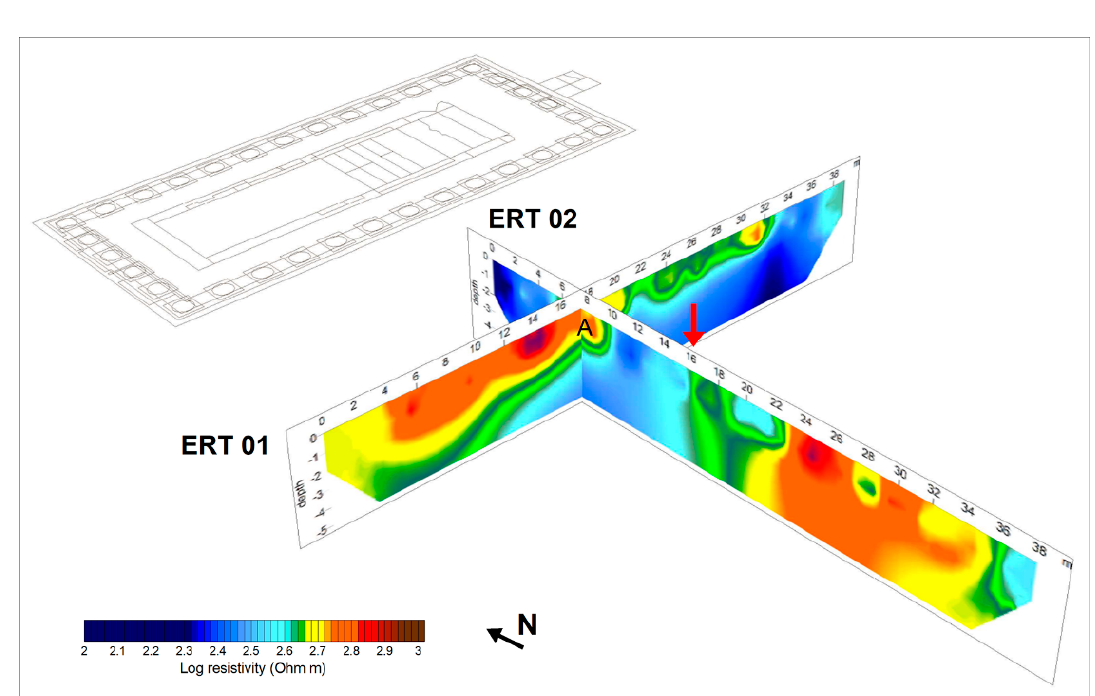
Figure 10. Three-dimensional view of ERT 01 and 02 and their spatial relationship with the temple.